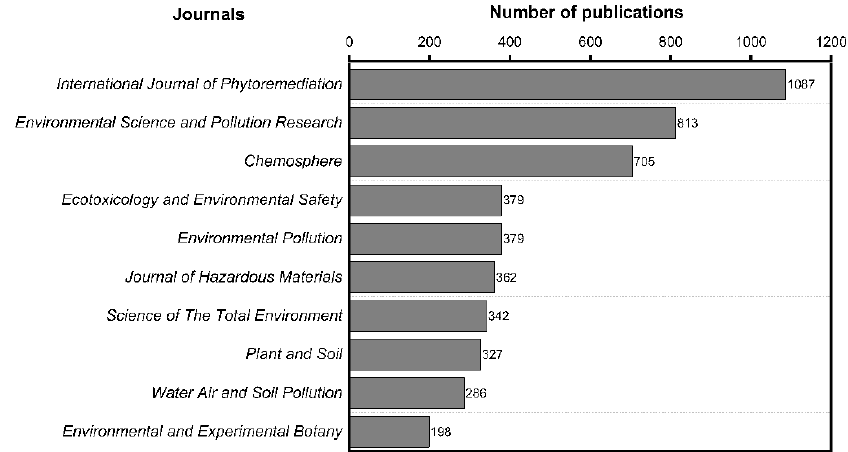
Figure 4. Top 10 journals publishing research on phytoremediation.